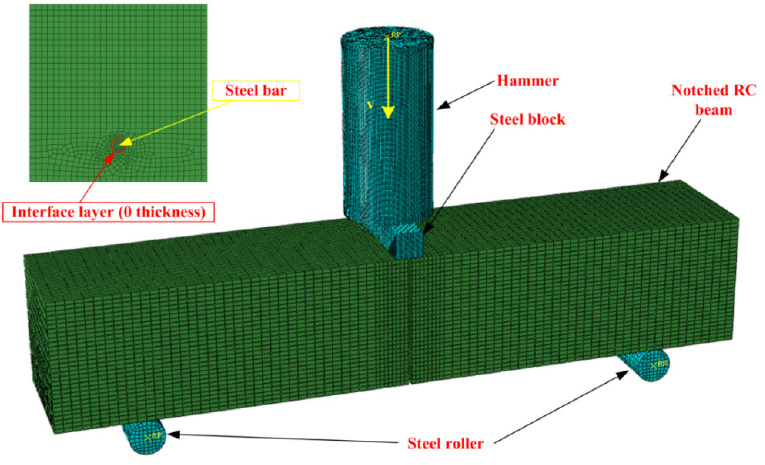
Figure 7. The numerical model for drop hammer impact system.